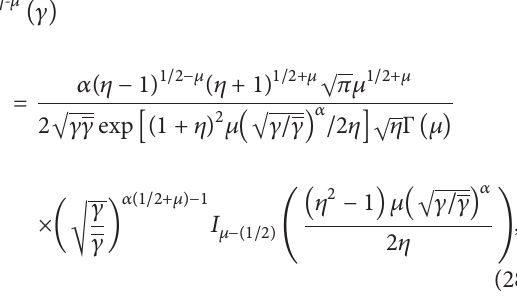
For instance, the bit error probability of the BPSK modulation over the pure AWGN channel as a function of the received SNR 𝛾 is given by